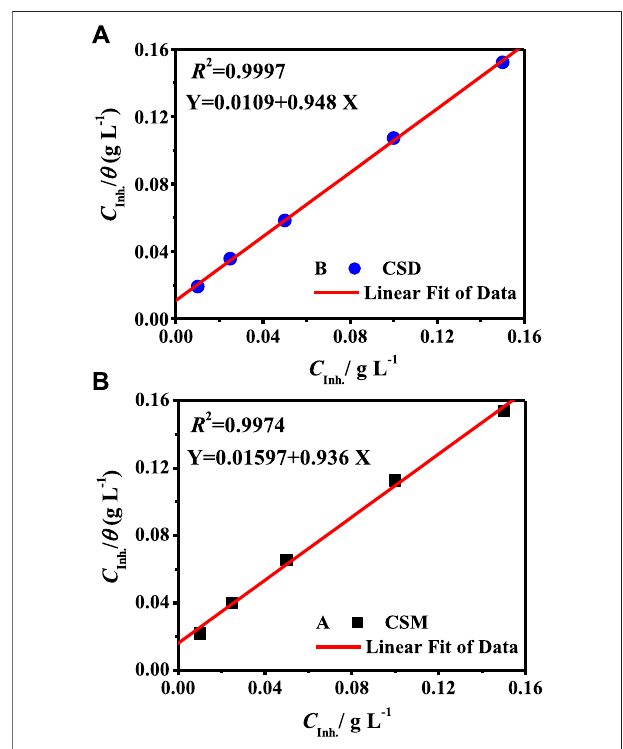
FIGURE7| C / θ vs. C inh pro fi lederivedfromLangmuirisothermmodelfor C-steel in 3.5% NaCl saturated with carbon dioxide at 50 ± 1 °